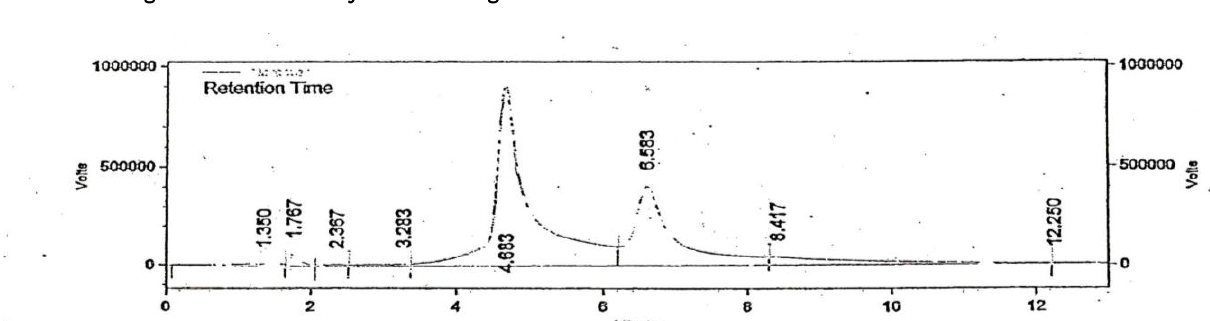
Figure2 : HPLC analysis of chlorogenic acid standard.